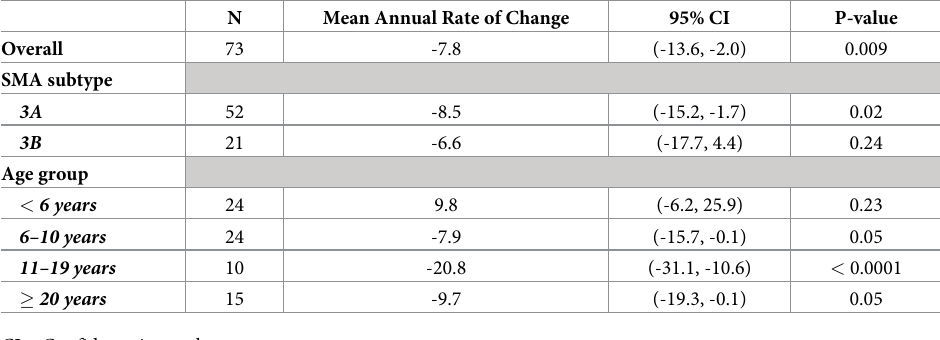
Table 2. Mean annual rate of change on the 6MWT, overall and by subgroup. N